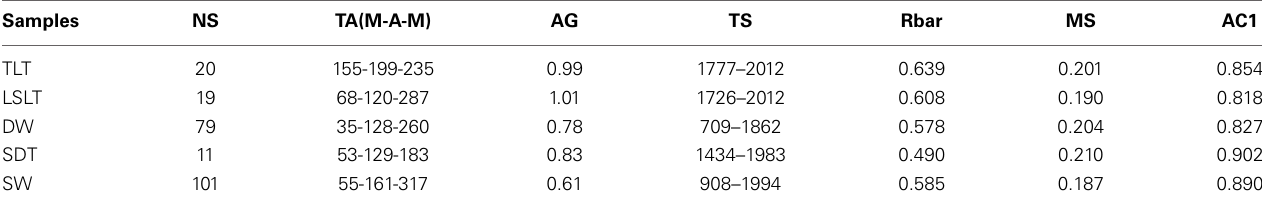
Table 1 | Statistics of the tree-ring samples used in the study.